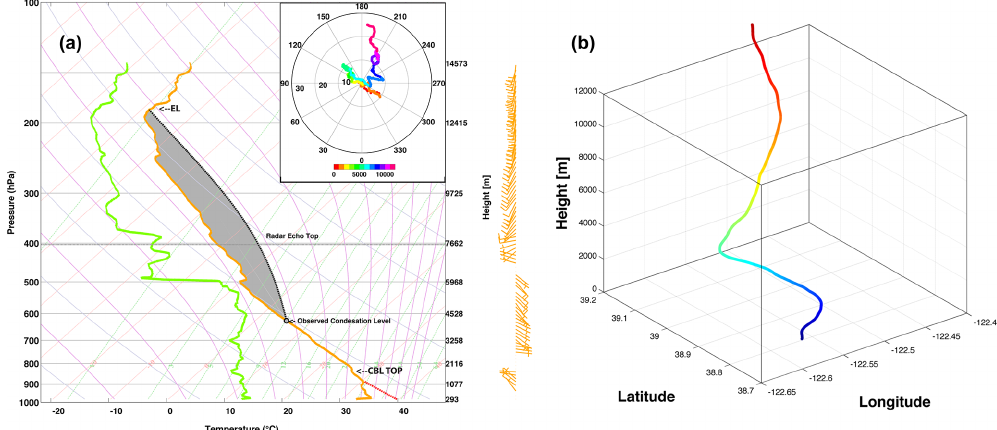
Figure 17. Thermodynamic analysis of the ambient environment during the Rocky Fire. (a) Observed sounding from 21:05PDT showing the adjusted boundary layer profile (dashed red line), the lidar-derived condensation level (gray circle), the moist-adiabatic ascent from the condensation level, and the radar-derived echo tops. The inset is a hodograph and the wind barbs on the right indicate how the wind speed and direction change with height. (b) Balloon ascent path showing the affect of wind shear on a buoyant parcel.